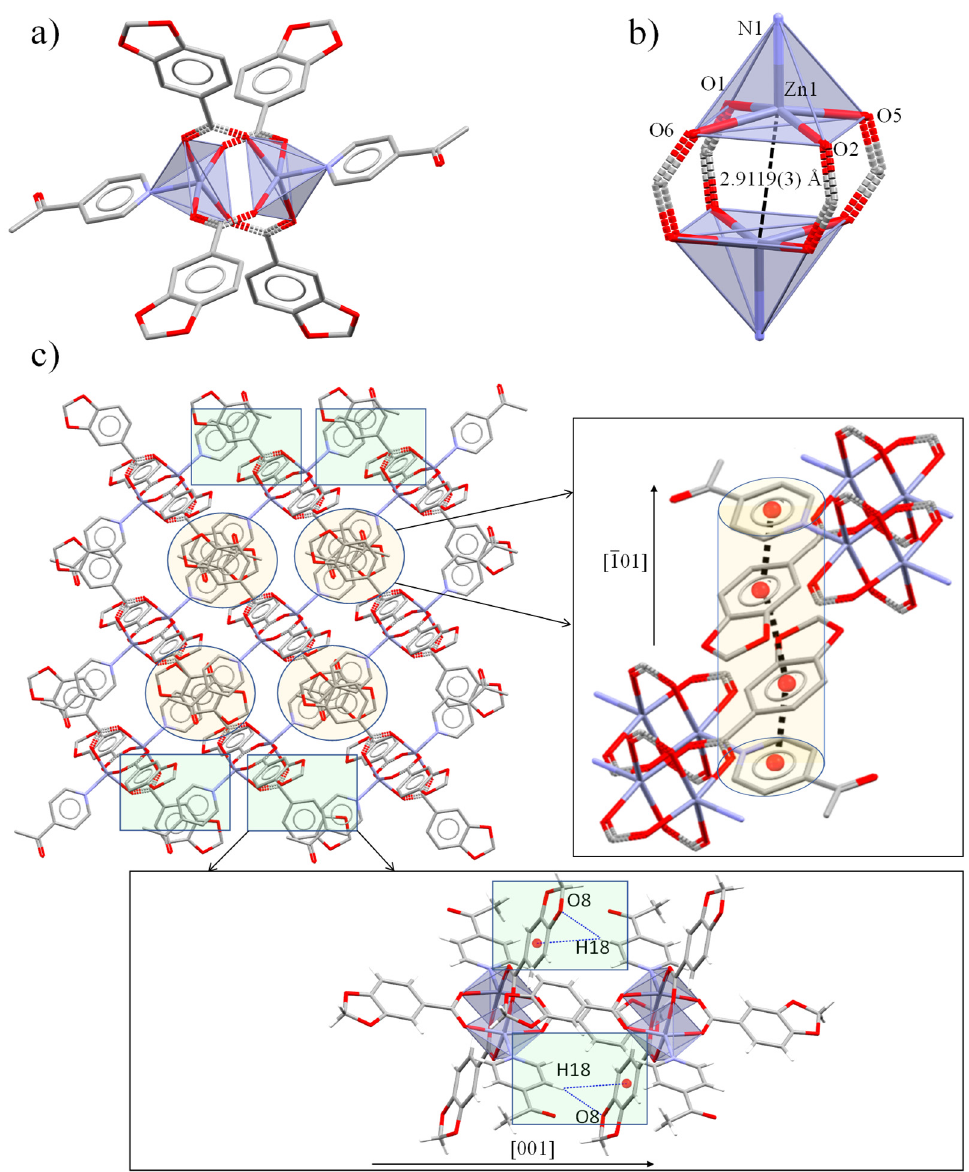
Figure 1. ( a ) Molecular paddle-wheel like structure of complex 1 and ( b ) Zn(II) metal core. ( c ) Su- Supramolecular assembly forming 2D sheets promoted by π · · · π supported by C-H · · · π and C-H ·· O pramolecular assembly forming 2D sheets promoted by π ··· π supported by C-H··· π and C-H··O in- interactions. In detail, π · · · π (light orange) and C-H · · · π /C-H · · · O (light green) associations between teractions. In detail, π ··· π (light orange) and C-H··· π /C-H···O (light green) associations between Pip Pip and 4-Acpy and 4-Acpy ligands.